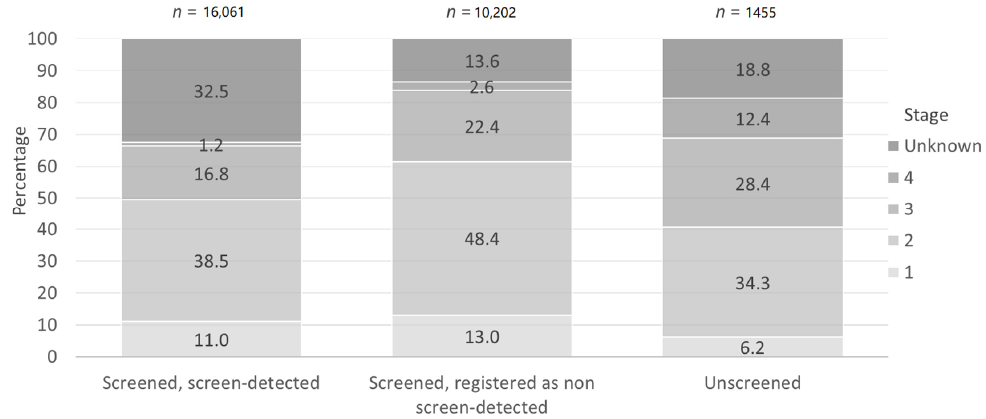
Figure 4. Cancer stage distribution in unscreened, screened non-screen detected and screened, screen detected groups.